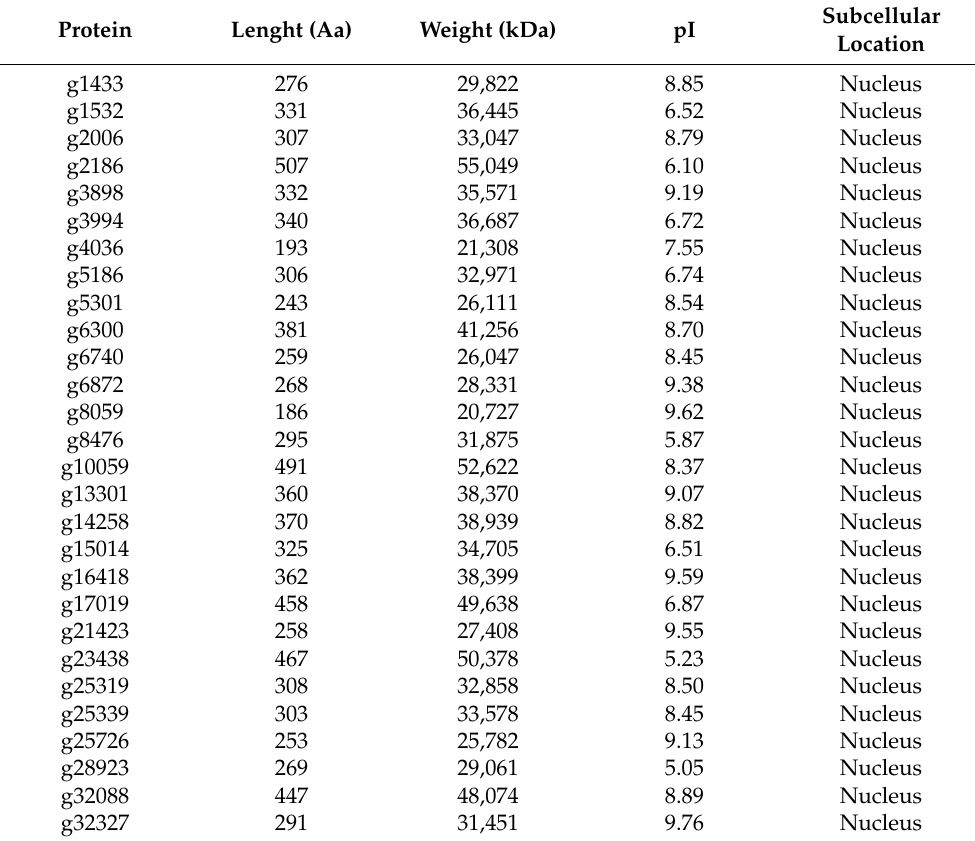
Table 1. Physicochemical properties and predicted subcellular location of Eugenia uniflora DOF proteins. Protein size is in amino-acid residues (Aa), molecular weight in kilo Daltons (kDa), and iso- electric point (pI) in